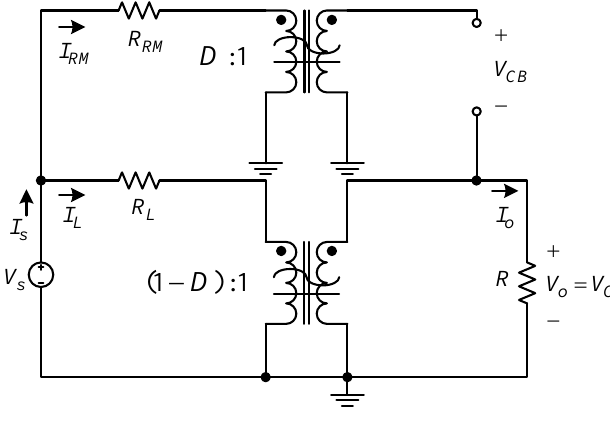
Figure 6. The equivalent circuit of the DC model of the proposed